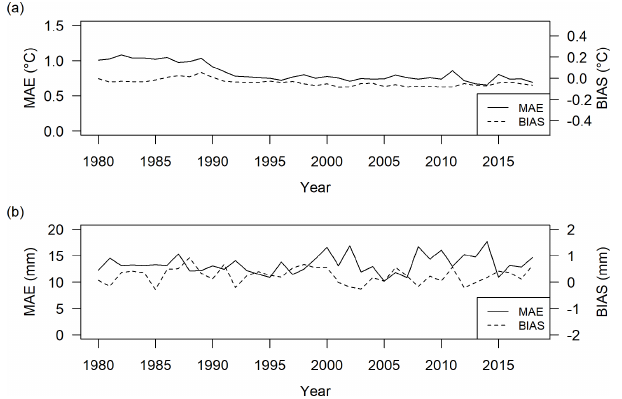
Figure 7. Annual series of mean monthly leave-one-out reconstruc- tion errors (MAE and BIAS) of (a) temperature and (b) precipi- tation over the study period for the available stations in Trentino- South